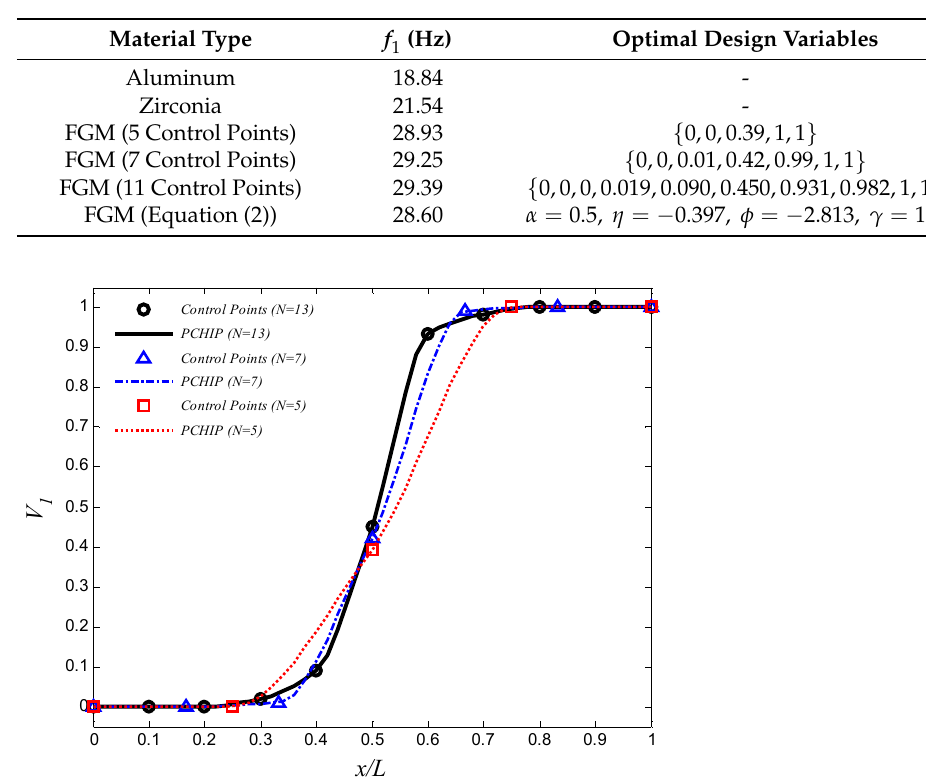
Table 6. The optimal frequencies and design variables of the first design problem.